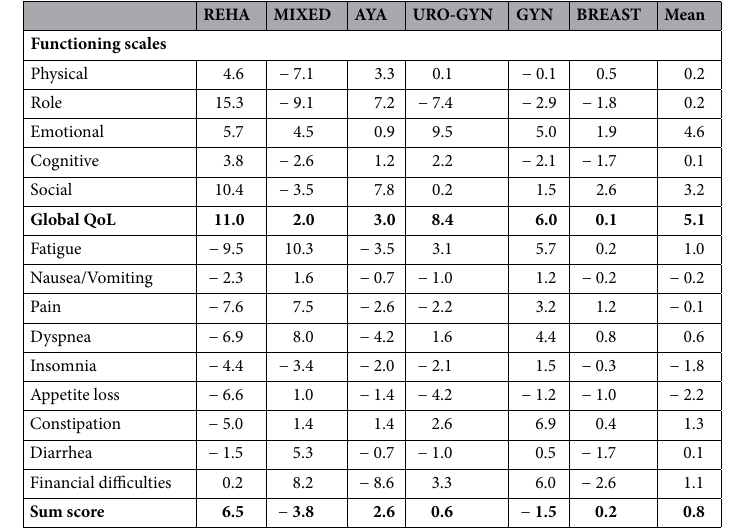
Table 3. t2-t1 mean score differences. Bold: global or summarizing scores.